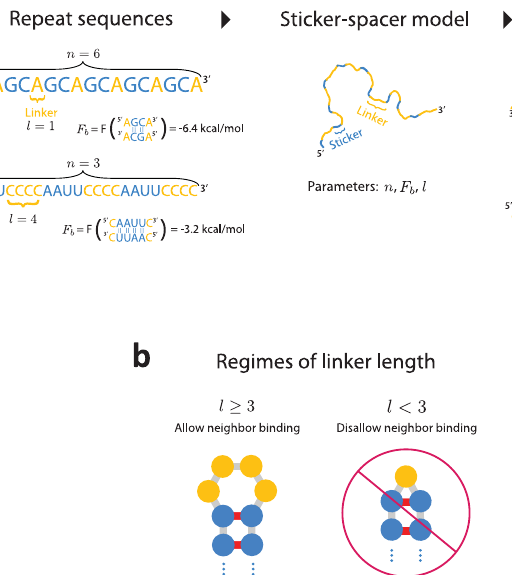
behavior depending on the length of the inert linkers. For long enough linkers, adjacent stickers can bind; for short linkers, they cannot because of hairpin size constraints. Structures visualized using forna 37 . c Regimes of sticker strength : For strong stickers, (almost) all of the sticker bonds are typically satis fi ed; for weak stickers almost none are; for intermediate strengths, the number of sticker bonds typically satis fi ed depends on a combination of the sticker strength and the mul- tiplicity of structures in which a given number of stickers is